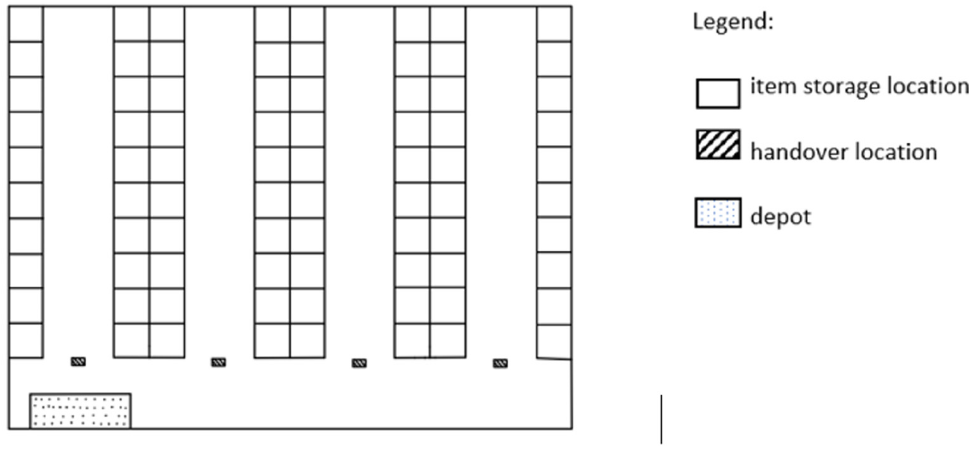
Figure 1. Warehouse with standard layout.